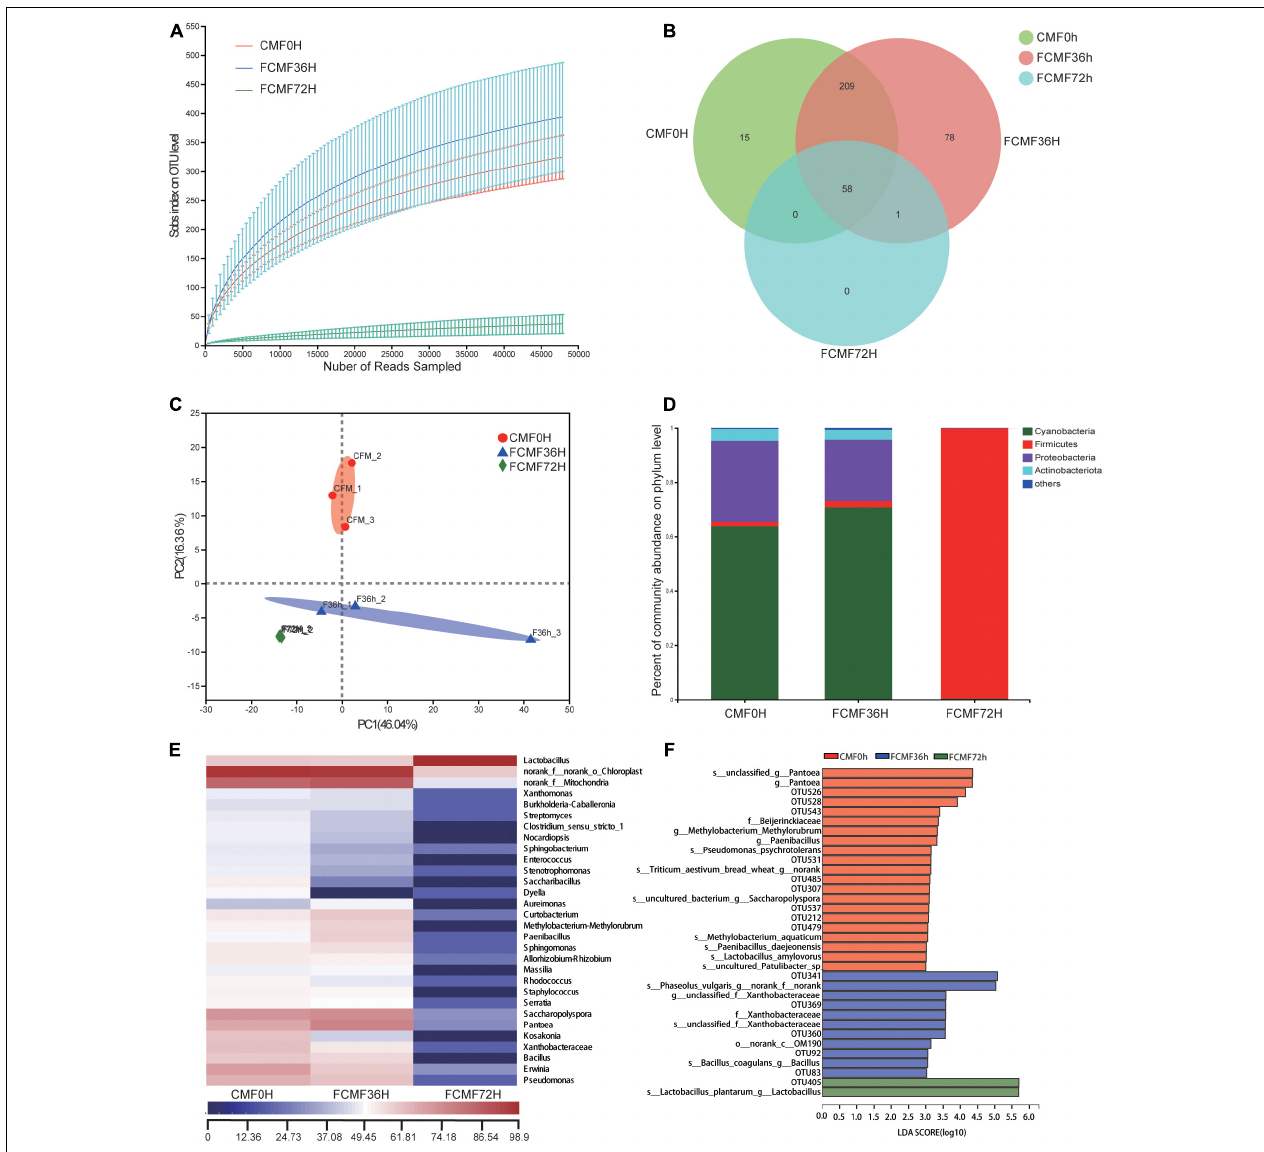
FIGURE 3 | Microbial diversity and bacterial community structure during two-stage solid-state fermentation (SSF) ( n = 3). (A) Observed operational taxonomic unit (OTU) line chart. (B) Venn diagram representing the common and unique OTUs found at each fermentation time point. (C) Principal-component (PC) analyses of samples conducted based on unweighted UniFrac distanced. (D,E) Phylum-level (D) and genus-level (E) compositions of the bacterial community in FCFM. (F) Linear discriminant analysis (LDA) effect size (LEFSe) histogram showing the LDA scores ( > 3.0) computed for features at the OTU level. Letters indicate the taxonomy of the bacteria: p, phylum, c, class; o, order; f, family; g,